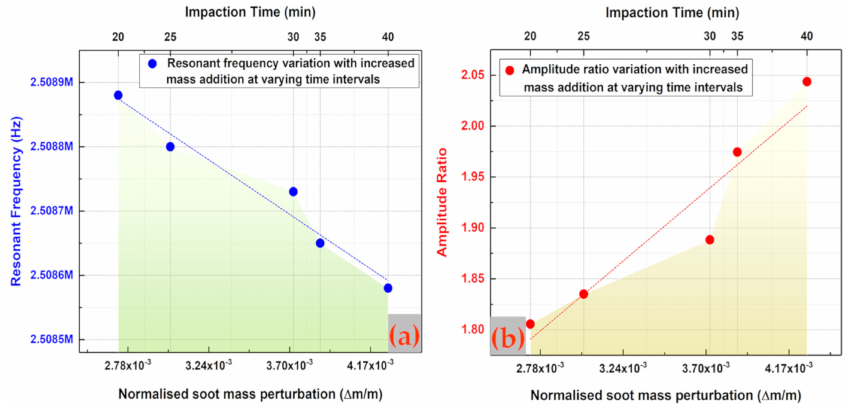
Figure 8. ( a ) Resonant frequency shift and ( b ) Amplitude ratio shift of the coupled MEMS resonators for 20 min of soot particle impaction at di ff erent time intervals on one of the coupled resonators following the initial 20 min stabilization period.